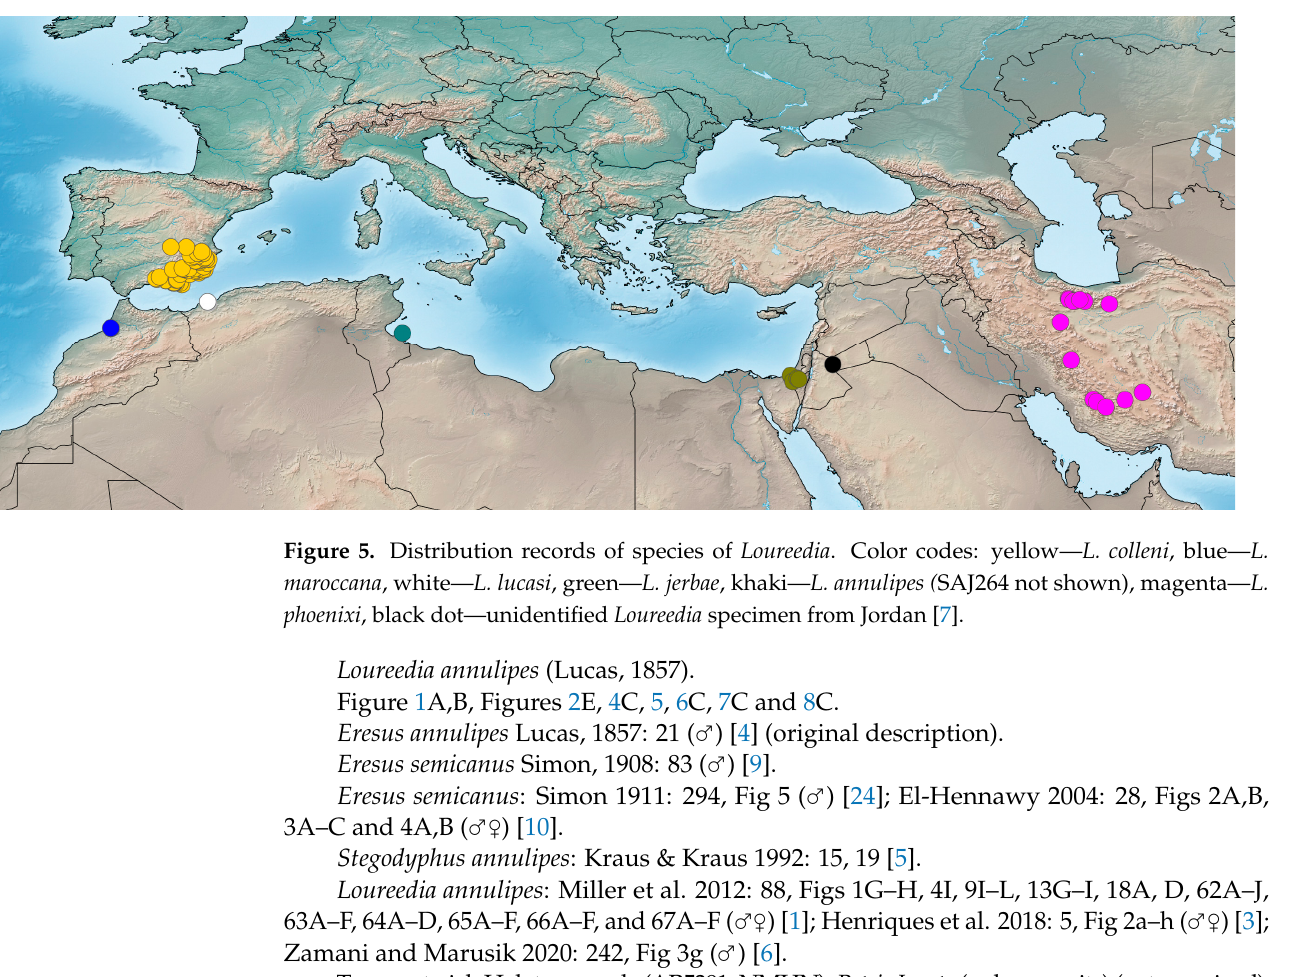
7 of 27 Figure 4. Conductors of six species of Loureedia (ventral view). ( A ) L. phoenixi ; ( B ) L. jerbae ; ( C ) L.